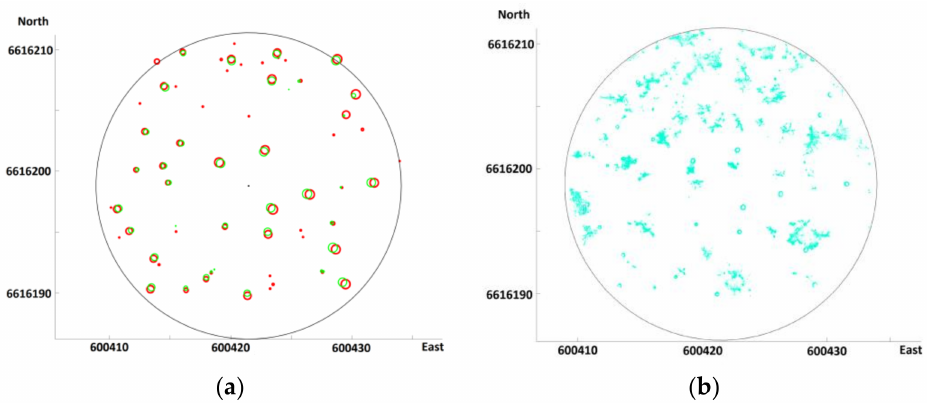
Figure 3. ( a ) Detected trees by HLS (green circle) and ground reference tree data (red circles). The size of the circle represents the DBH and the coordinate system is EUREF89 UTM zone 32. ( b ) HLS data used to extract trees.